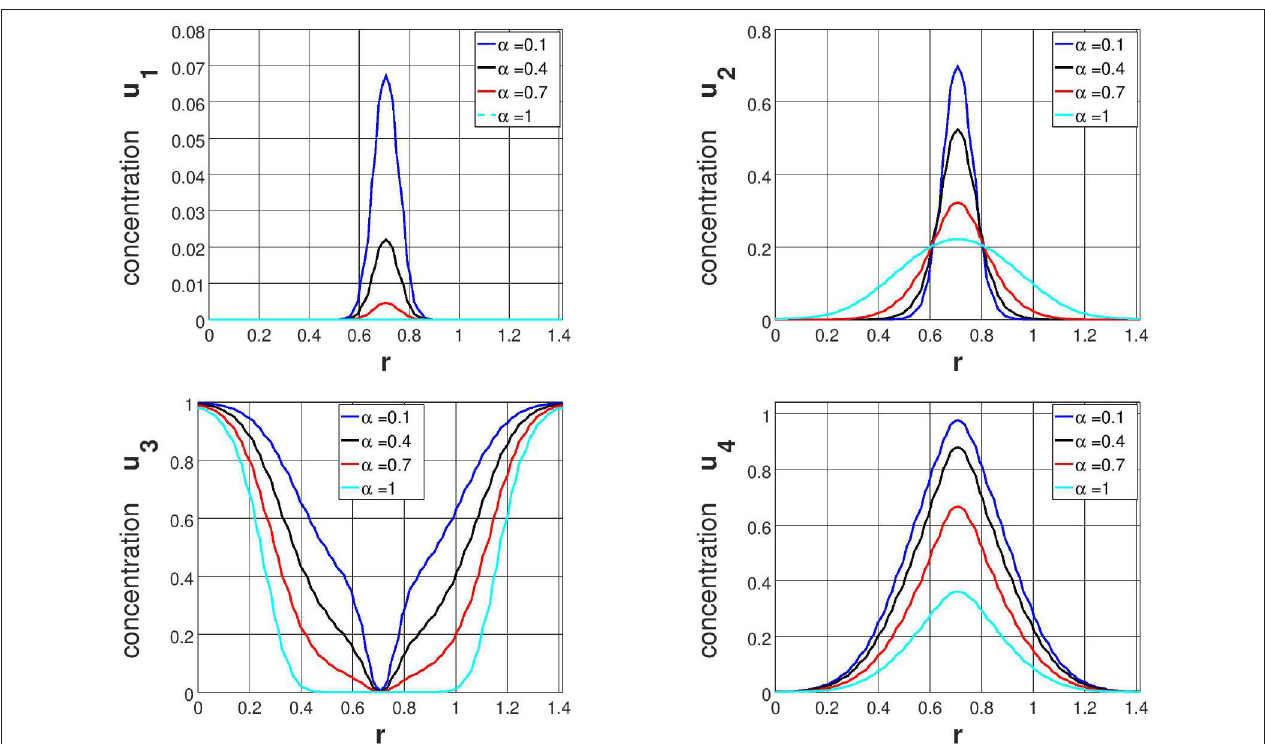
FIGURE 6 | Evaluation of u 1 , u 2 , u 3 , and u 4 at t = 20 along the line y = x .